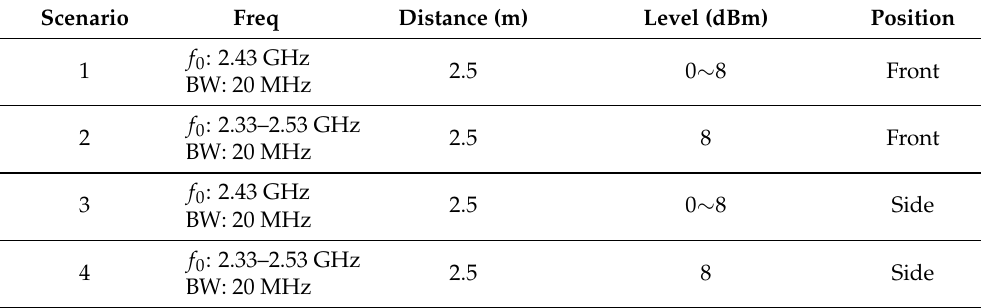
Table 8. Experiment scenarios for camera module using digital communication scheme.